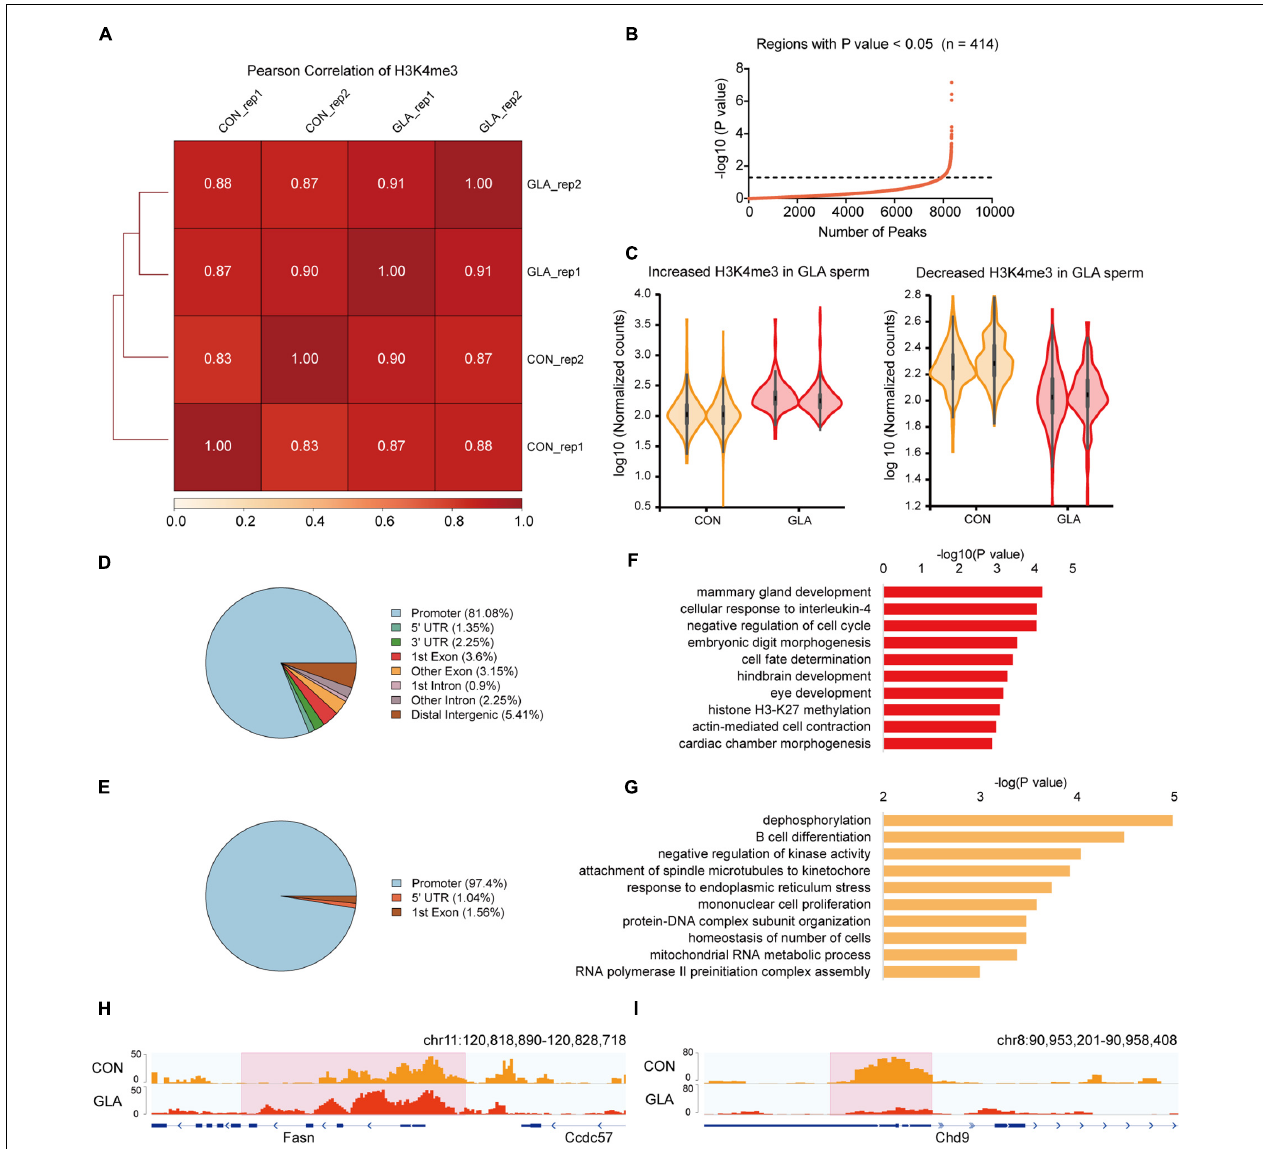
FIGURE 2 | GLA-induced H3K4me3 alterations in mouse sperm. (A) Correlation matrix showing Pearson correlation coefficient of H3K4me3 between replicates of CON and GLA sperm. (B) Selection of regions with P -value < 0.05. The black dashed line corresponds to the boundary of P -value = 0.05. (C) Violin plots showing increased and decreased H3K4me3 in GLA sperm. Two replicates in each group are in the same color. (D,E) Pie chart showing the genomic distribution of regions with increased (D) and decreased (E) H3K4me3 signals in GLA sperm. (F,G) Selected significant pathways from Gene Ontology analysis on genes with increased (F) or decreased (G) H3K4me3 signals in GLA sperm. (H) Integrative Genomics Viewer tracks showing increased H3K4me3 on Fasn in GLA sperm. (I) Integrative Genomics Viewer tracks showing decreased H3K4me3 on Chd9 in GLA sperm. Pink box indicates regions with differential H3K4me3 signals ( P -value <